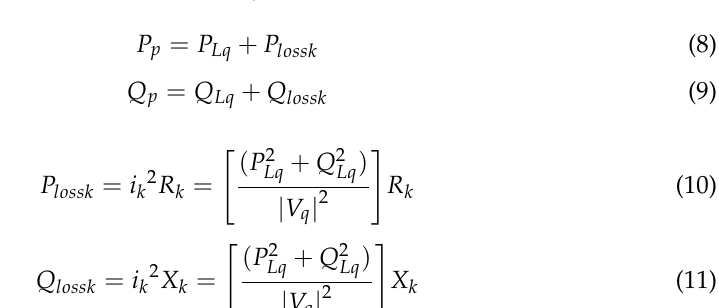
Figure 1. Two nodes representation of distribution